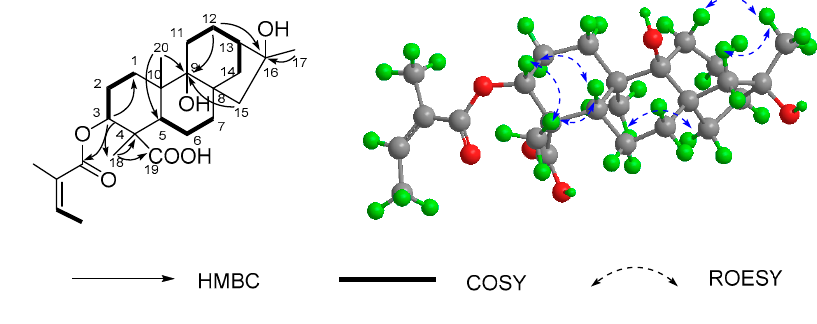
Figure 2. Key 2D-NMR data of 1 .